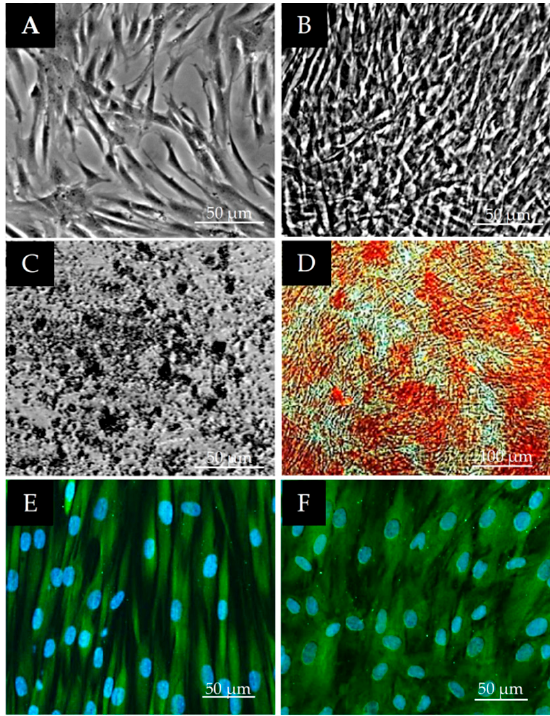
Figure 3. Differentiation analysis of DPSCs in osteogenic direction. ( A-C ) phase contrast microscopic images on day 0 ( A ) and on day 21 of osteogenic differentiation in control ( B ) and osteogenic ( C ) groups. ( D ) day 21 osteogenic group with von Kossa staining. ( E,F ) immunofluorescent detection of osteogenic markers on day 21 of osteogenic differentiation: osteonectin–ON (E) and bone sialoprotein–BSP (F). The bars indicate 50 µm or 100 µm. Green fluorescence shows specific immunostaining (Alexa Fluor 488) while blue shows the cell nuclei (DAPI).